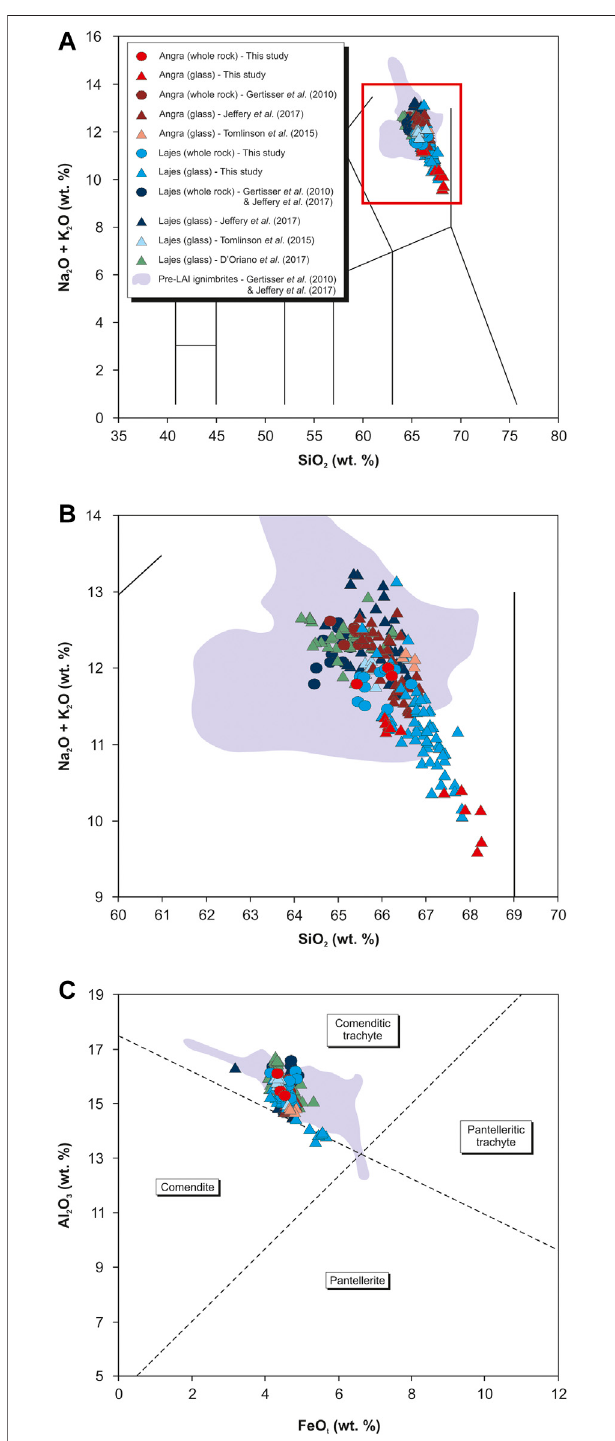
FIGURE12| Majorelementclassi fi cationplotsfortheAngraandLajesignimbrites. Whole rock and groundmass glass analyses are distinguished for clarity. Ignimbrites that pre-datetheLAIarealsoshownforreference. (A) ChemicalcompositionsoftheAngraand Lajesignimbritesplottedinthetotalalkalivs.silicadiagram(LeMaitreetal.,2002). (B) Enlargementofpanel12A,highlightingthechemicalvariationwithintheLAI. (C) Peralkaline compositions for the Angra and Lajes ignimbrites plotted on the Al 2 O 3 vs. FeO T classi fi cation scheme for oversaturated peralkaline rocks (Macdonald, 1974).